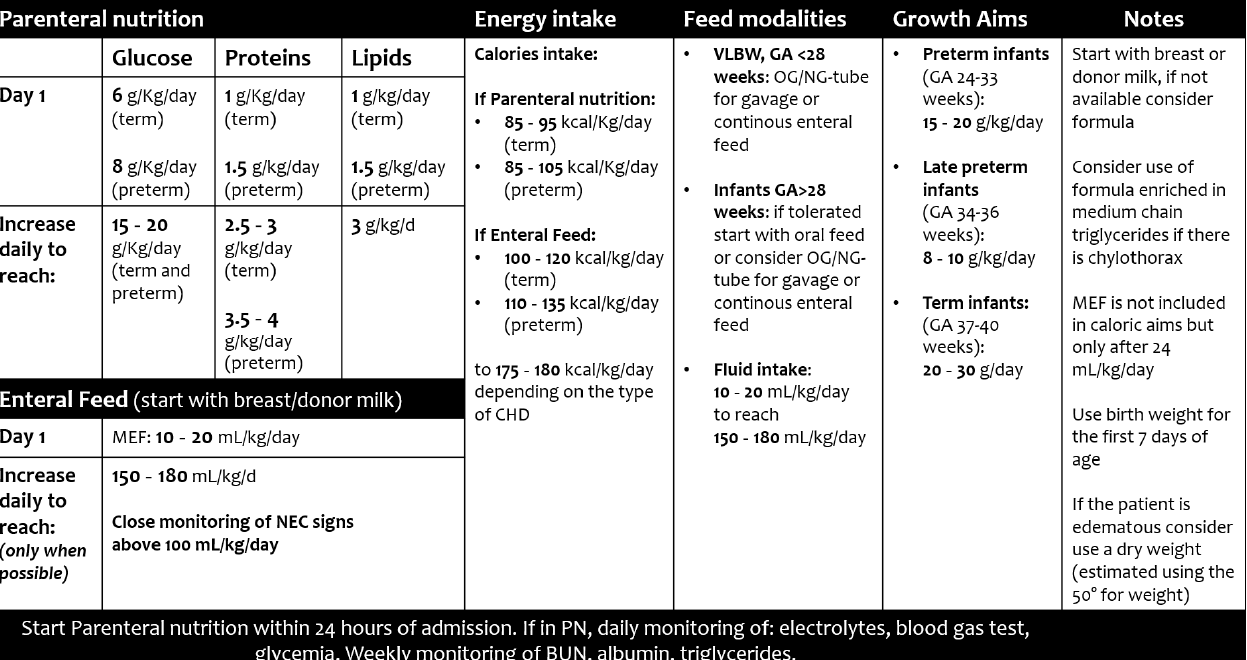
Figure 3. Target energy intake and growth aims in newborn infants with congenital heart diseases. GA, gestational age; OG, orogastric; MEF, minimal enteral feeding; NEC, necrotizing enterocolitis; NG, nasogastric.